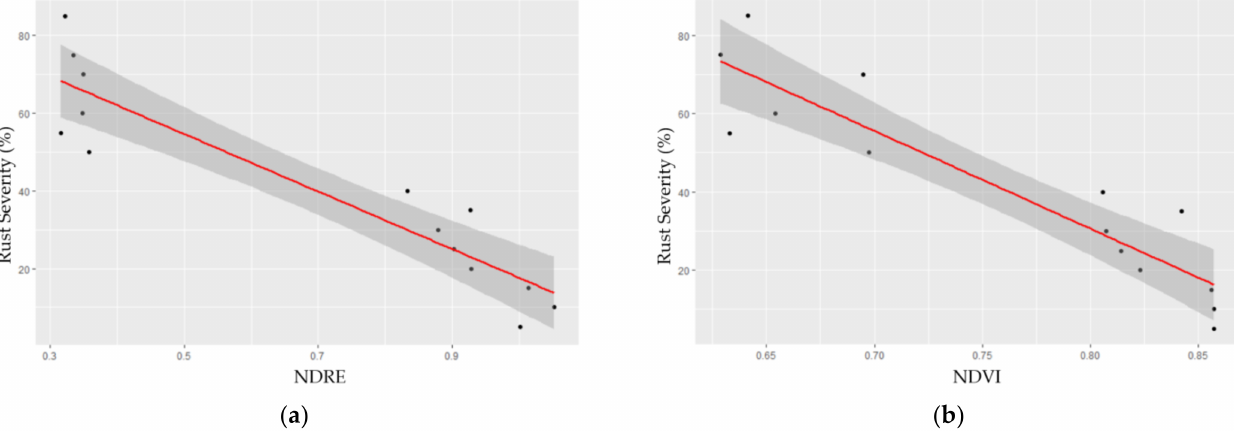
Figure 2. Model comparison between rust severity with ( a ) normalized difference red edge (NDRE) and ( b ) normalized difference vegetation index (NDVI). NDRE showed a slightly higher R-squared compared with NDVI. X -axis represents the vegetation index, and y -axis represents the rust severity measured on the